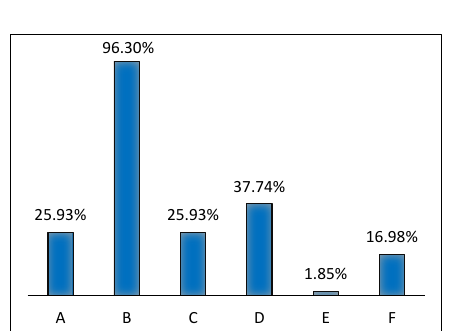
Figure 2. What were benefits of received peer reviews for you?